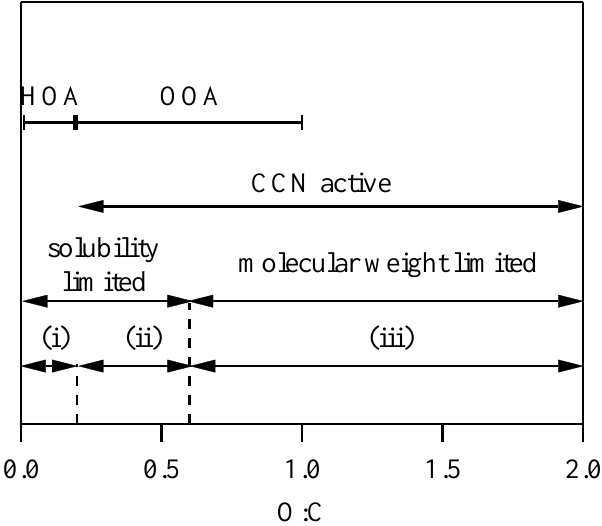
Fig. 5. Summary of the relationship between CCN activation mechanism and O:C ratio. Regions representing (i) insoluble, (ii) slightly soluble, and (iii) highly soluble particles are highlighted. The O:C ratios of hydrocarbon-like organic material (HOA) and oxygenated organic material (OOA) are also shown (Ng et al.,